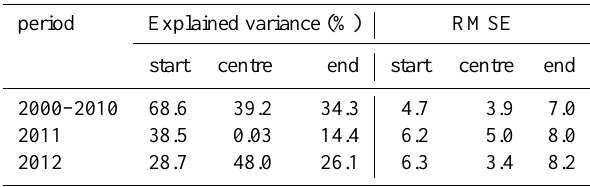
Table 2. Statistical correlation between simulated and observed rag- weed pollen season for fitting 2000–2010 and prediction (2011,